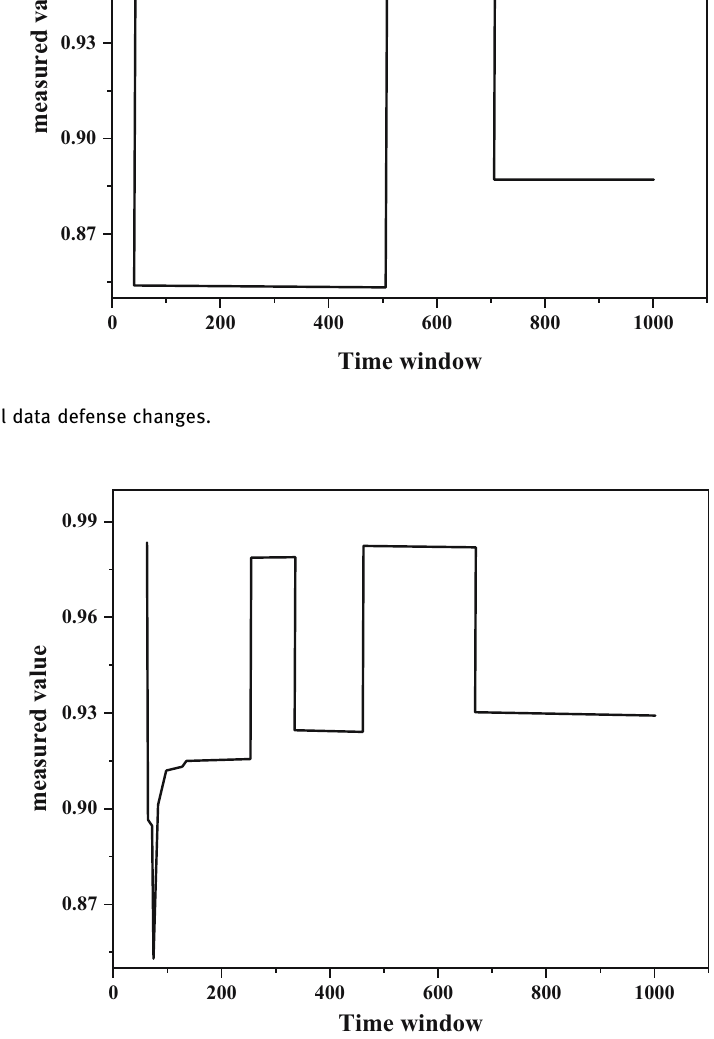
Figure 7: Simulation of the defense situation of network security incidents being